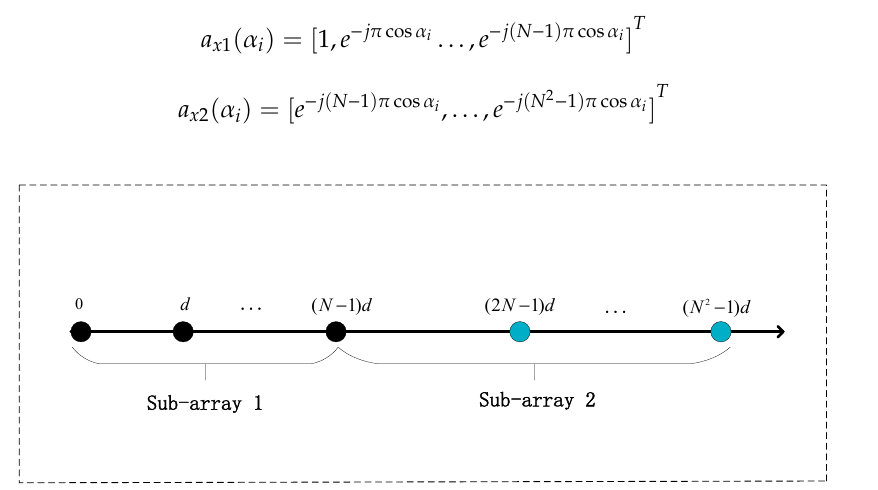
Figure 2. Subarray selection from the nested arrays of the X-axis. Black dots indicate sensors of sub-array 1 with inter-spacing d , while blue dots show sensors of sub-array 2 with inter-spacing Nd , the N -th sensor is shared by both sub-arrays, symbol denotes the location of sensor.